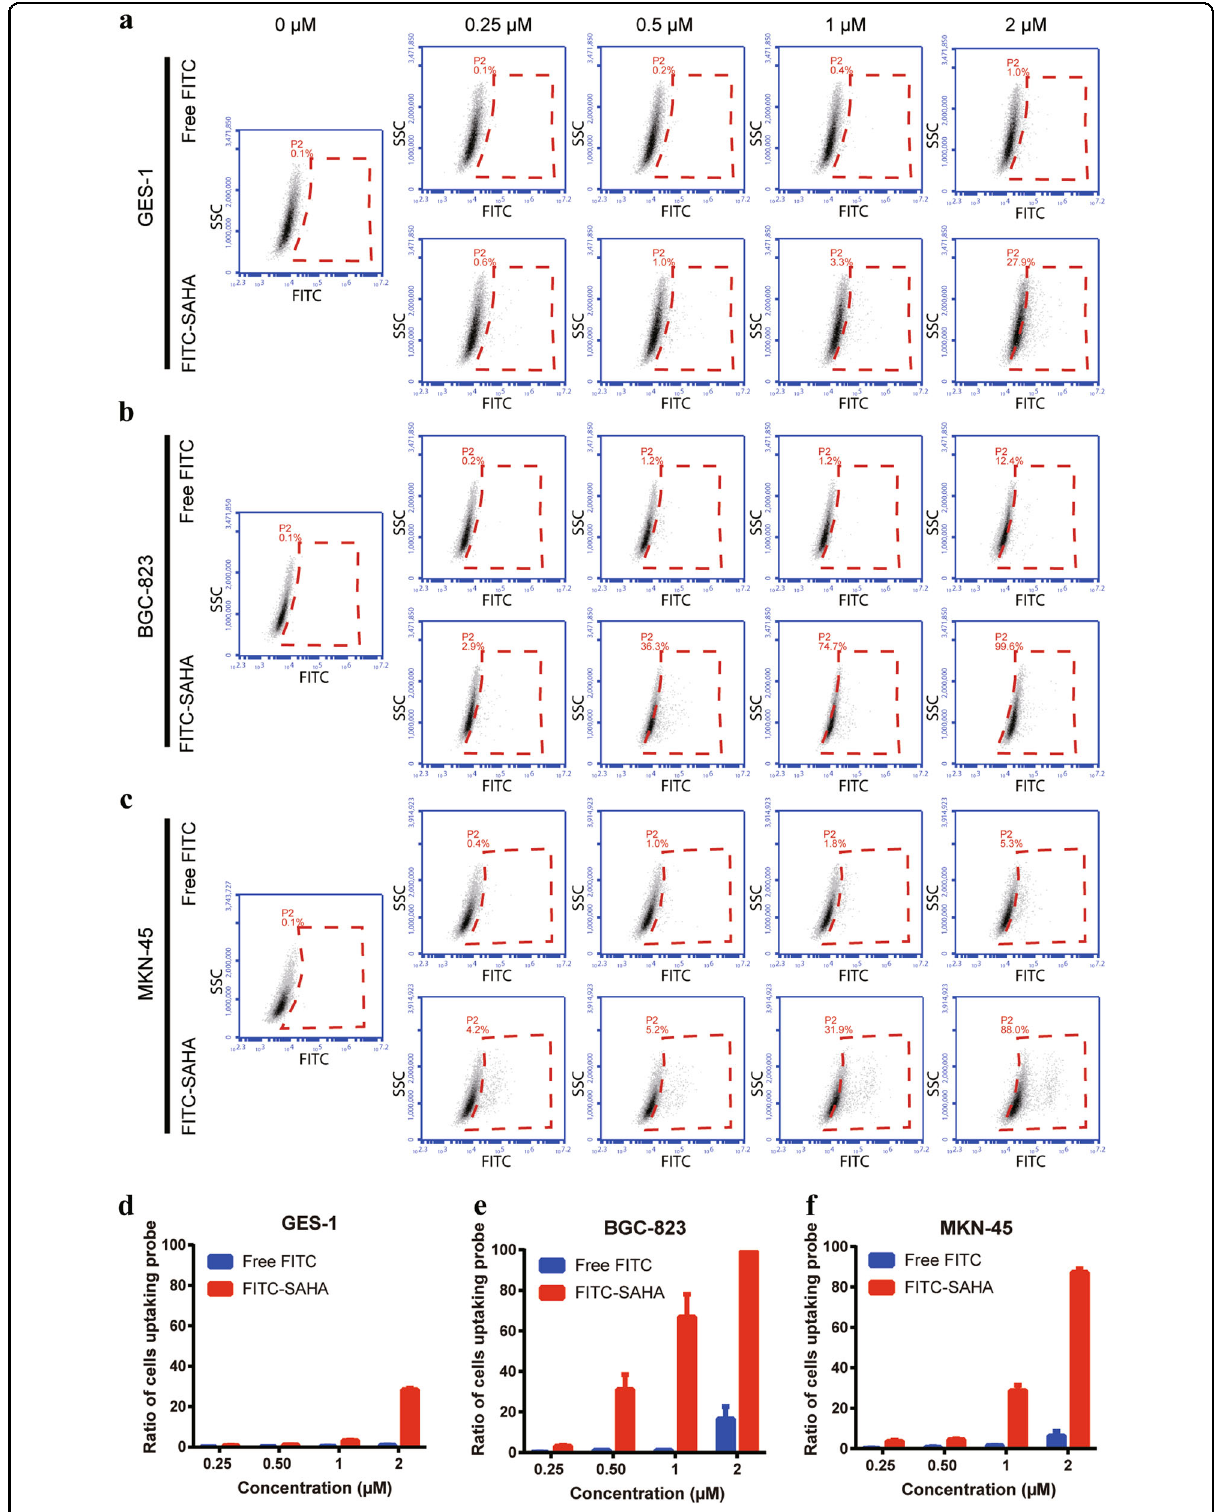
Fig. 2 Binding capacity and af fi nity of SAHA for GC cells. a – c The GES-1, BGC-823, and MKN-45 cell lines were incubated with various concentrations of FITC-SAHA for 4 h. Fluorescence was analyzed by fl ow cytometry. GES-1, BGC-823, and MKN-45 cells treated with various concentrations of free FITC were used as controls. d – f The proportion of positive cells labeled by FITC-SAHA or free FITC was calculated. All experiments were repeated three